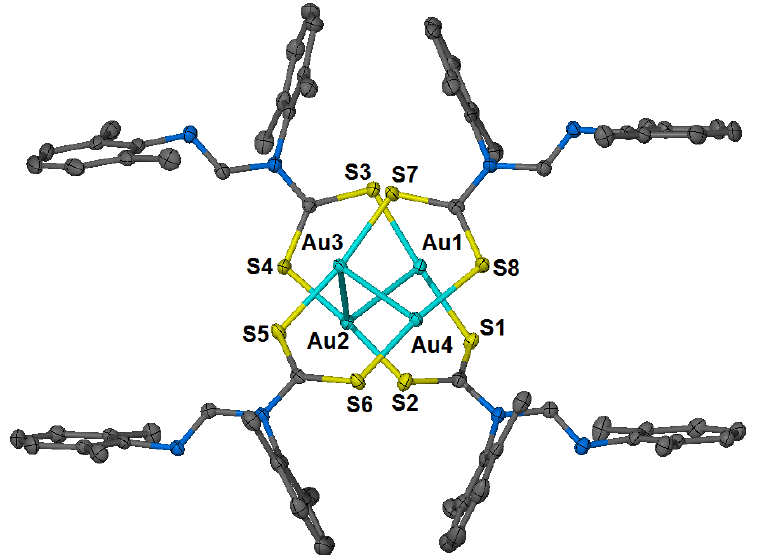
Figure 4. Thermal ellipsoid plot of two units of 4 shown at the 50% probability level. Hydrogen atoms have been omitted for